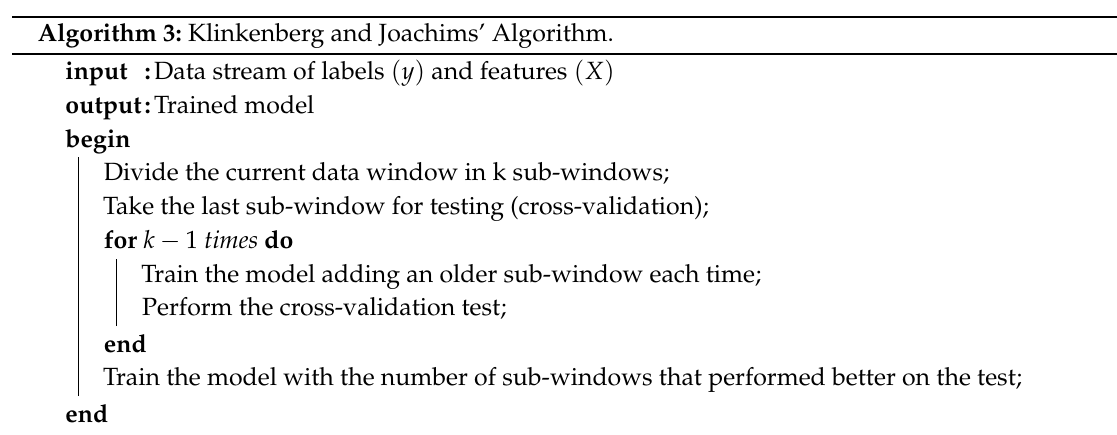
Algorithm 3: Klinkenberg and Joachims’